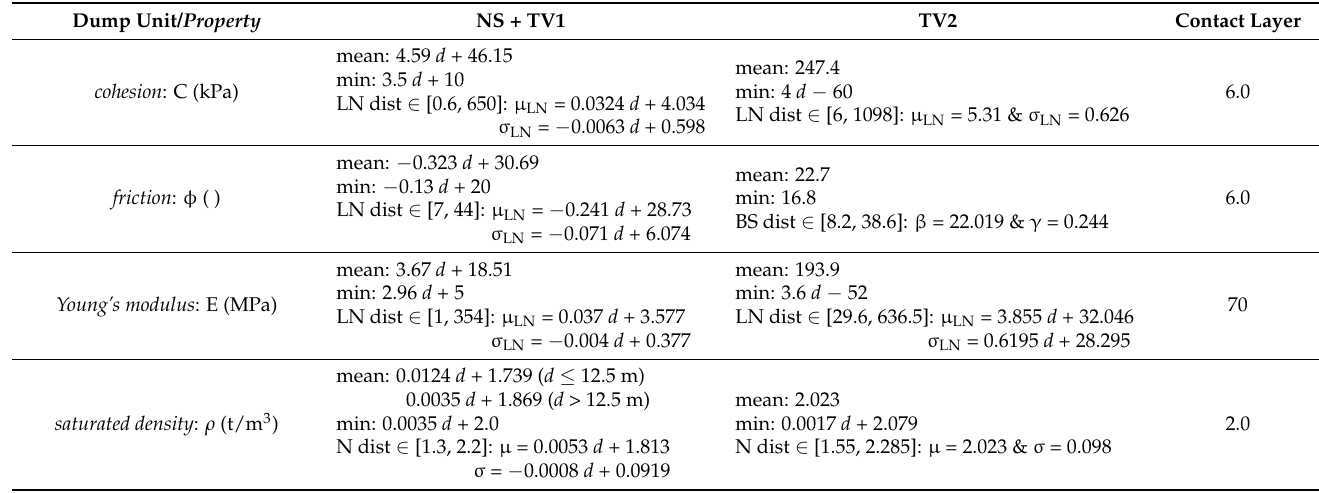
Table 1. Statistical properties of dump units. N, LN & BS dist: Normal, Log-normal and Birnbaum- Saunders distributions; d :